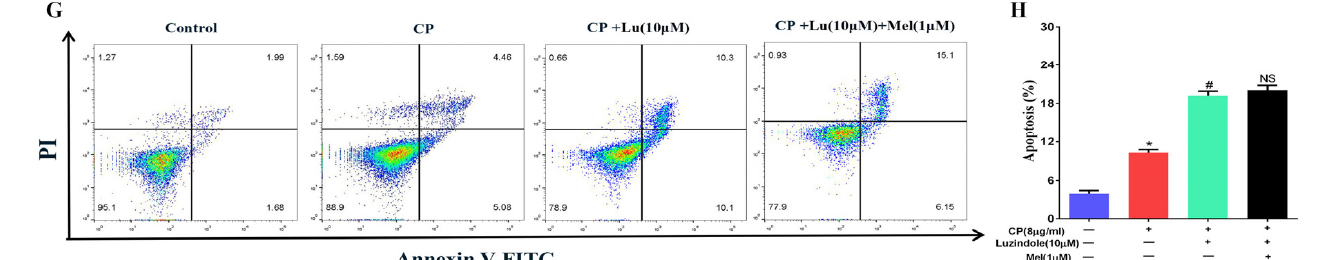
Figure 11. Melatonin protects Leydig cells from cisplatin-induced oxidative damage by activat- ing the MT1/MT2-mediated SIRT1/Nrf2 signaling pathway. ( A ) Determination of MT1 and MT2 protein levels was performed by Western blotting in Leydig cells treated with Luzindole or Luzin- dole and melatonin. The blots were quantified using Image J software. ( B ) Determination of Nrf2, HO-1, and NQO1 protein levels was performed by Western blotting in Leydig cells treated with Luzindole or Luzindole + melatonin. The blots were quantified using Image J software. ( C ) Determi- nation of SIRT1, SOD1, and SOD2 protein levels was performed by Western blotting in Leydig cells treated with Luzindole or Luzindole + melatonin. The blots were quantified using Image J software. ( D ) Determination of MT1 and MT2 protein levels was performed by Western blotting in control, CP, Luzindole + CP, and Luzindole + melatonin + CP groups. The blots were quantified using Image J software. ( E ) Determination of Nrf2, HO-1, and NQO1 protein levels was performed by Western blotting in control, CP, Luzindole + CP, and Luzindole + melatonin + CP groups. The blots were quantified using Image J software. ( F ) Determination of SIRT1, SOD1, and SOD2 protein levels was performed by Western blotting in control, CP, Luzindole + CP, and Luzindole + melatonin + CP groups. The blots were quantified using Image J software. ( G ) Flow cytometry was used to detect apoptosis in control, CP, Luzindole + CP, and Luzindole + melatonin + CP groups. ( H ) Percentages of the apoptotic cells are shown. CP, cisplatin. Mel, melatonin. NS, no significance. Data are presented as the mean ± SEM ( N = 4 per group). * p < 0.05 compared with controls. # p < 0.05 compared with CP groups. NS compared with Luzindole groups or CP + Luzindole